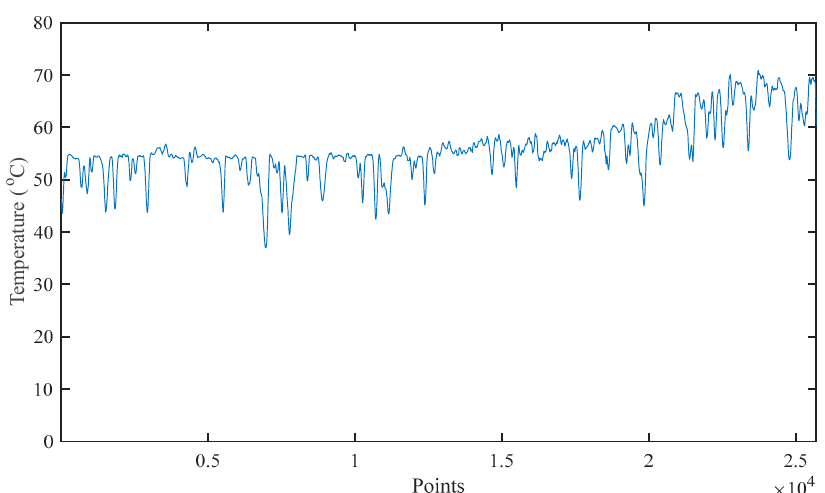
Figure 8. Actual ambient temperature in the wind farm (Case 1).